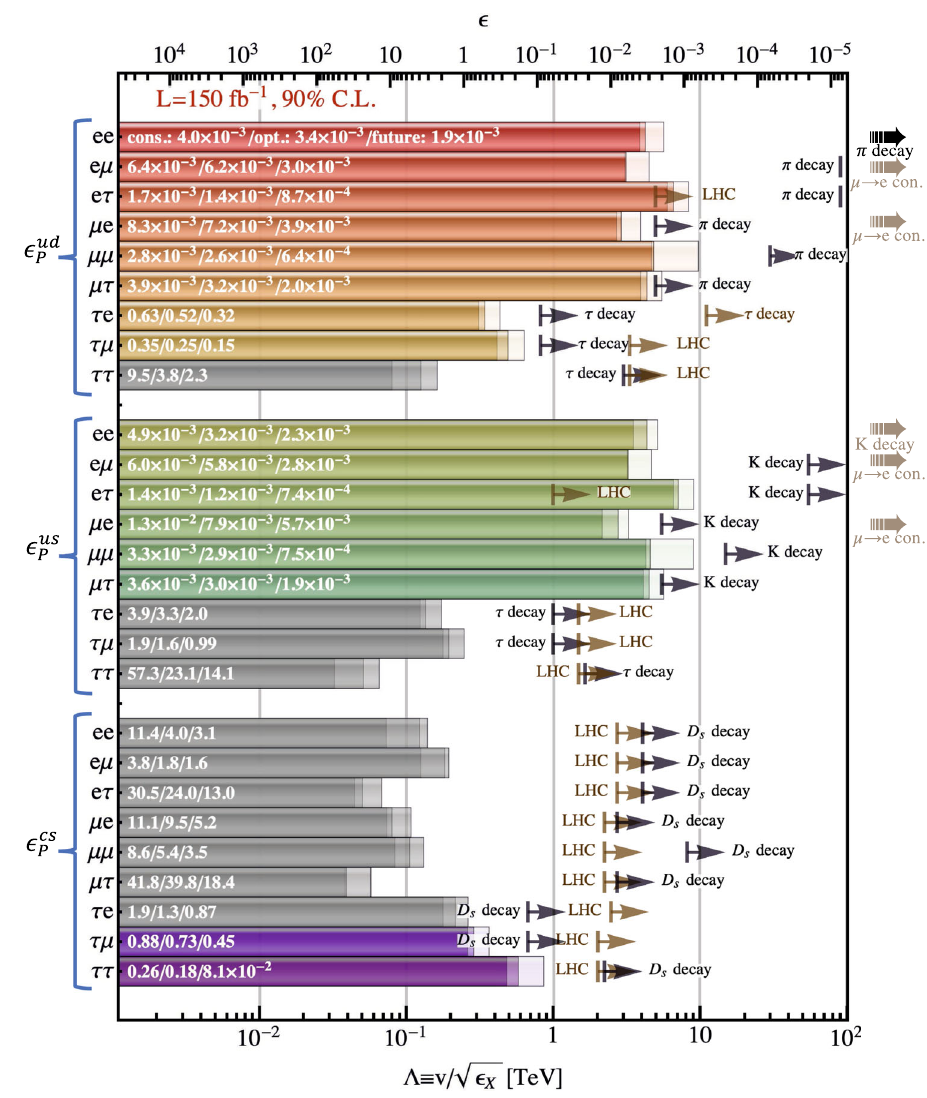
Fig. 2 Current and future projections for the sensitivity to pseudo-scalar CC operators. The projected constraints from FASER ν experiment are shown in colored/grey bars. The black and brown arrows show the corresponding constraints from low energy meson decay experiments and high energy SMEFT constraints from LHC, respectively. Figure taken from Ref. [100], see [100] for more